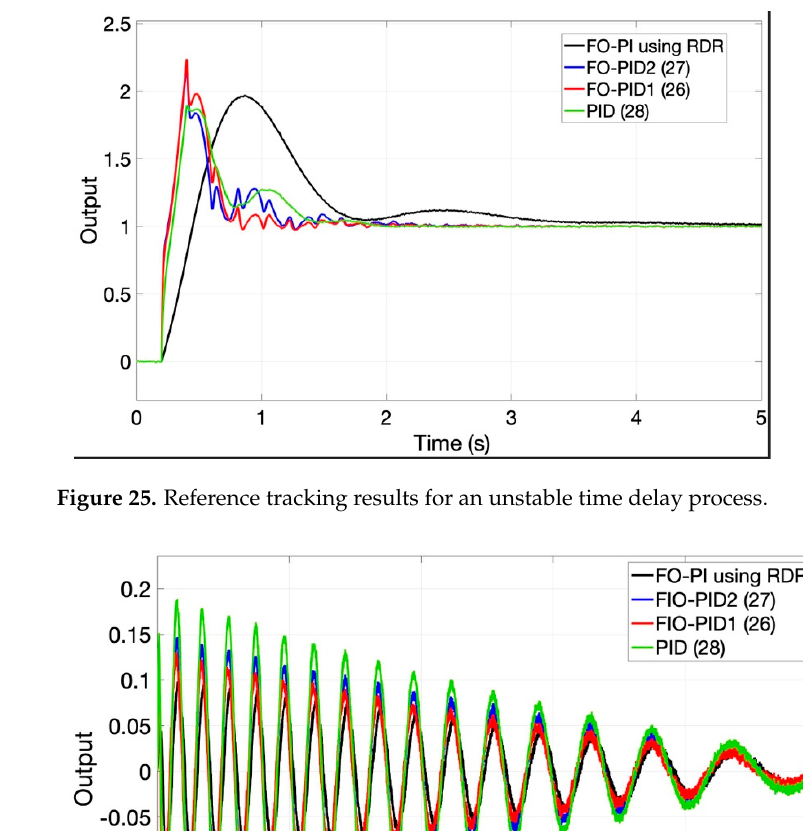
Figure 25. Reference tracking results for an unstable time delay process.